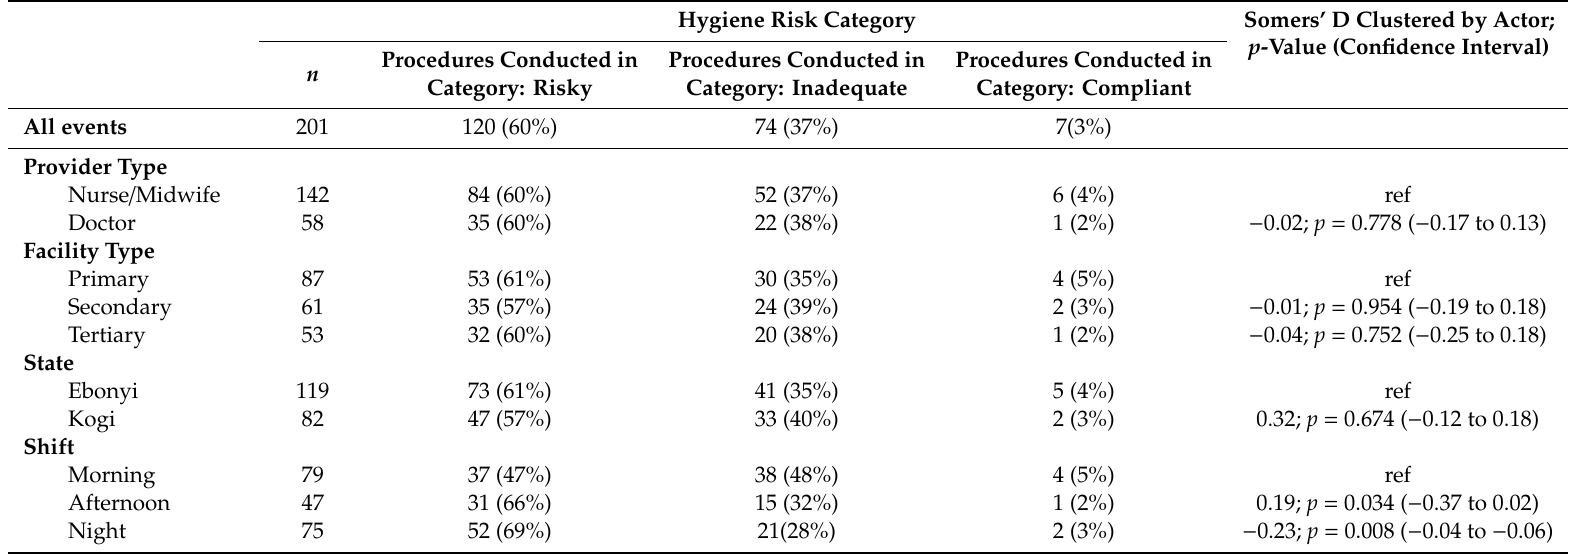
Table 2. Hygiene category (using simplified hygiene scoring) during mother-specific procedures requiring aseptic technique during labour and delivery by provider type, facility type, state, and shift